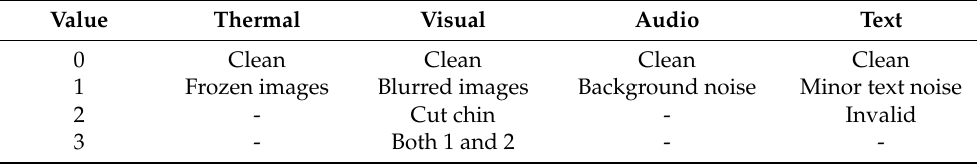
Table 3. Legend for data types and detected